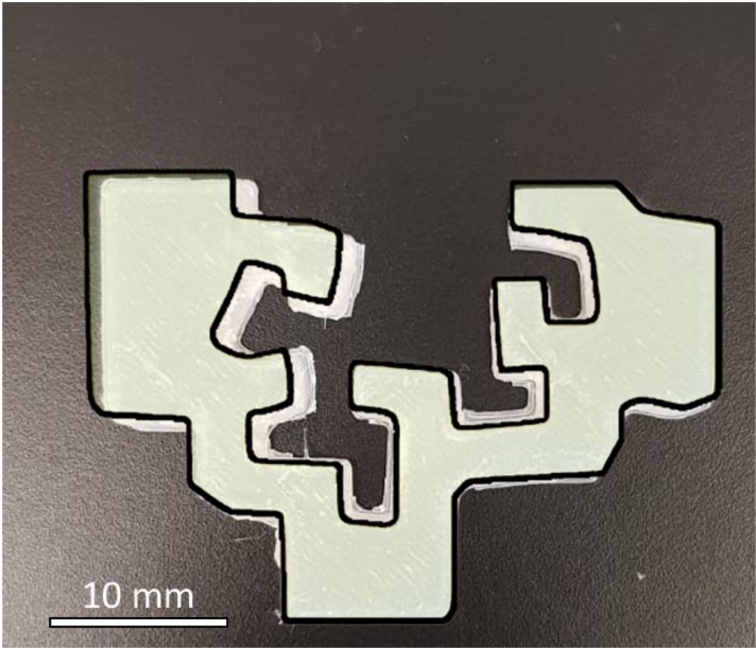
Figure 8. Image of the printed logo of the UPV/EHU with a dimensional comparison with the